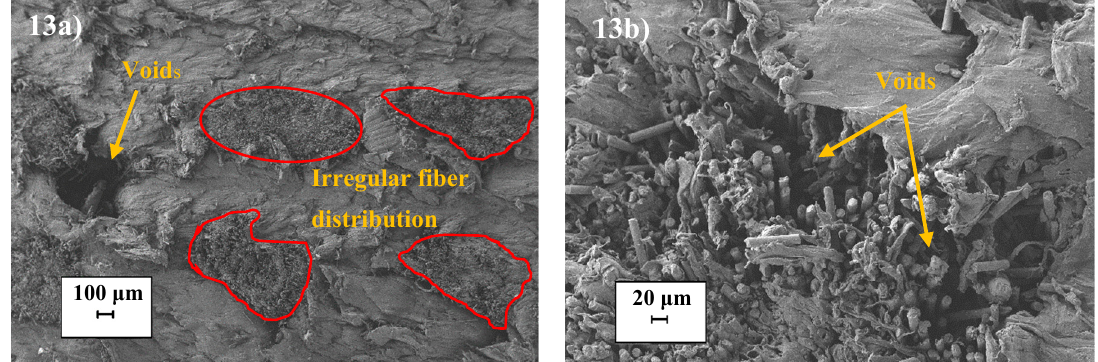
Figure 13. 3 K fibers sample before mechanical tests; ( a ) fiber distribution; ( b ) interface voids. J. Manuf. Mater. Process. 2019 , 3 , x FOR PEER REVIEW